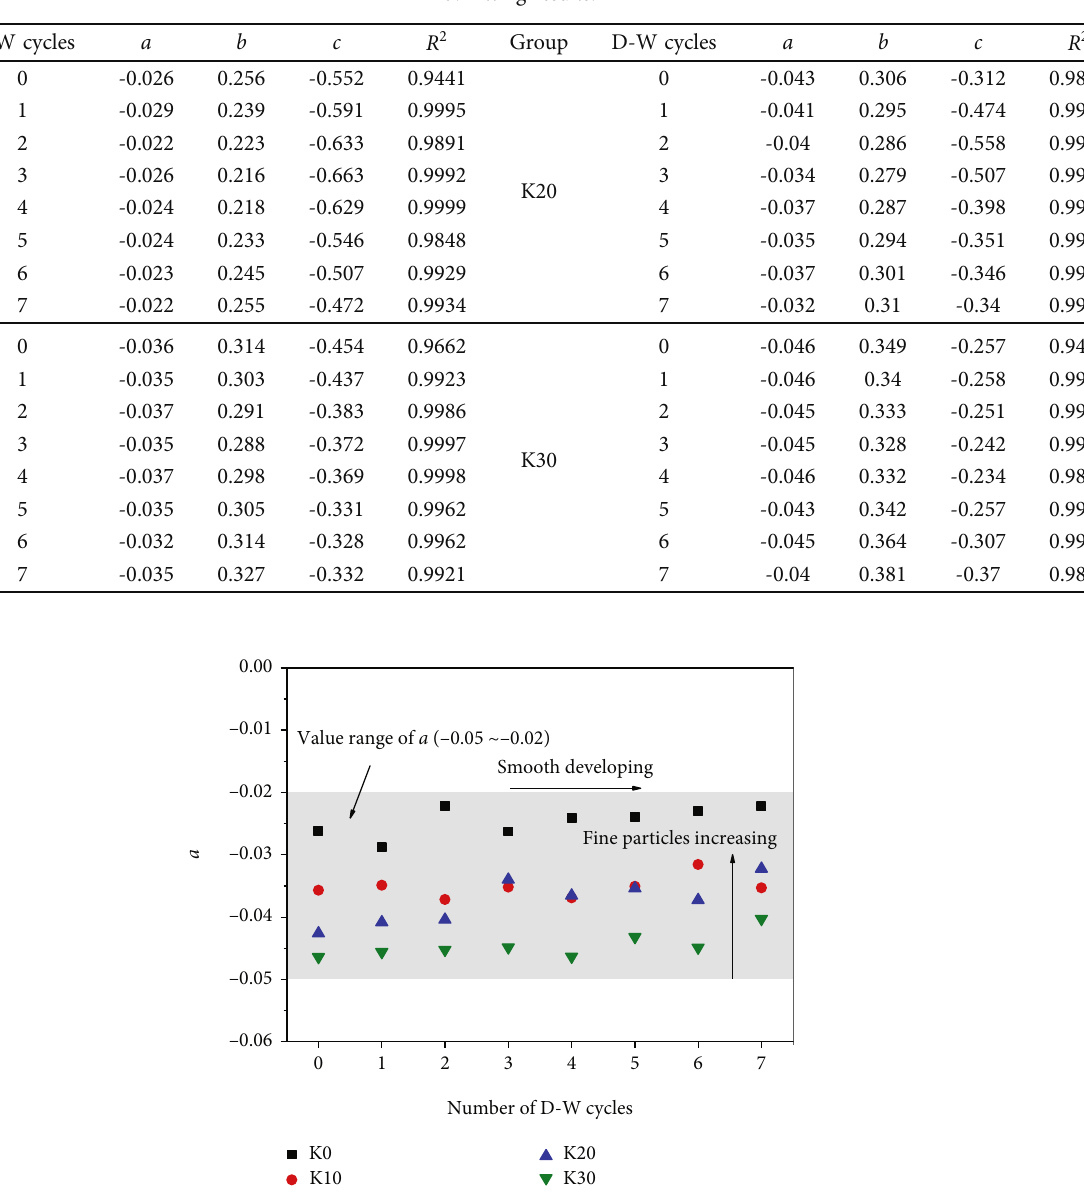
Table 5: Fitting results.